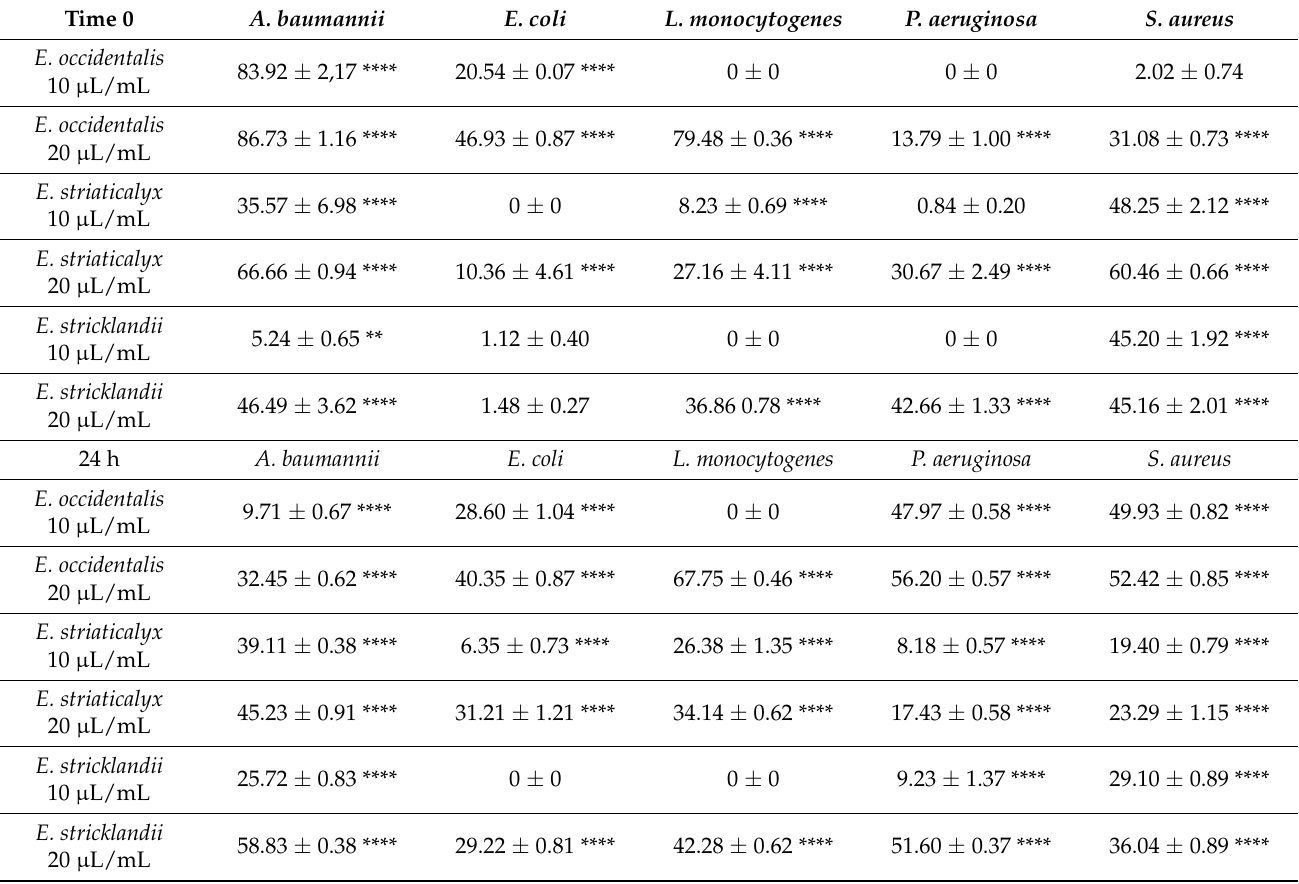
Table 6. Percent inhibition of two doses of the EOs on biofilm formation of A. baumannii , E. coli , L. monocytogenes, P. aeruginosa and S. aureus , at 0 and 24